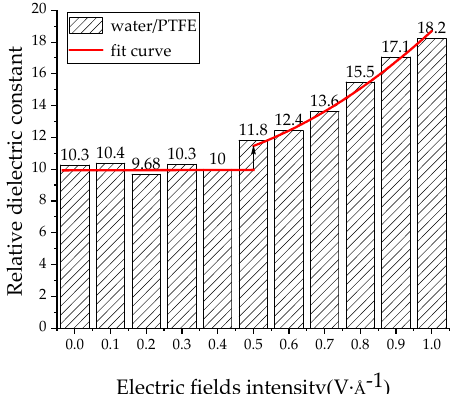
Figure 14. Variation of relative dielectric constant of the water / PTFE model with electric fields.